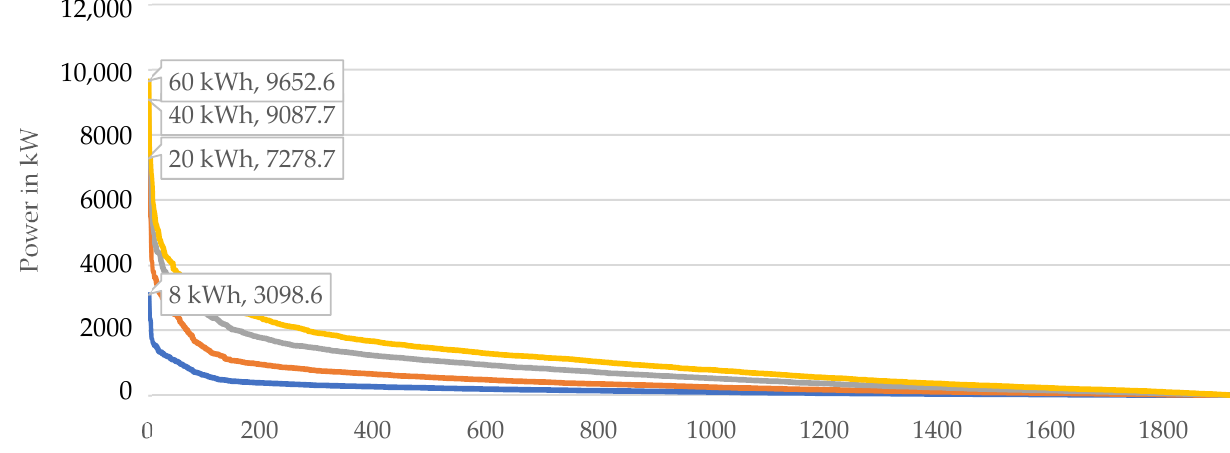
Figure 13. Sorted summed connector power when employing the CO 2 optimisation strategy. For example, if during each charging process 40 kWh should be charged, during ~200 h of the observed 1921 h, the chargers feed in power at a rating of 4000 kW or more.